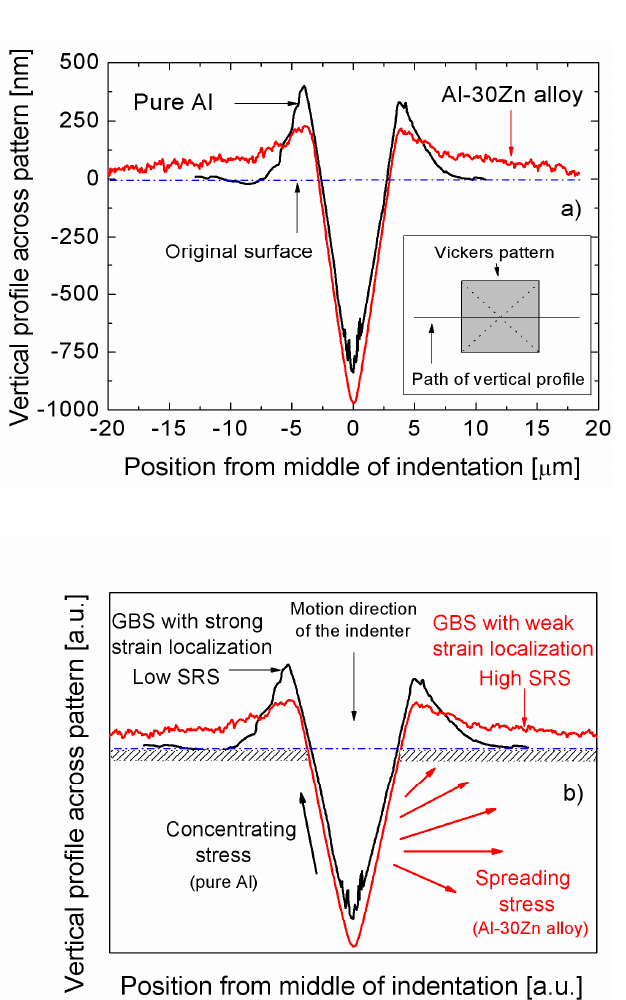
Figure 10. Vertical profiles across the centers of the Vickers indents ( a ) showing the difference in the profiles of UFG pure Al and Al-30Zn and ( b ) schematic picture of the deformation profile under the Vickers indenter and the correlation between grain boundary sliding and SRS. Reproduced with permission from [70]. Copyright 2020, Wiley.